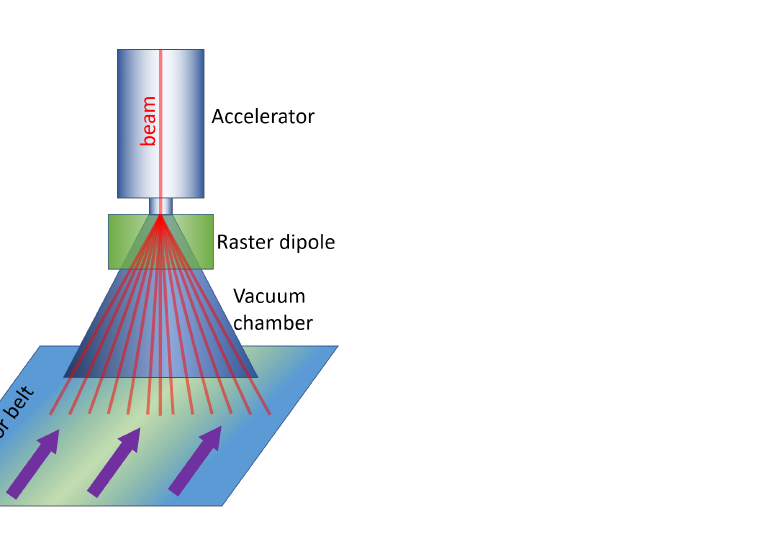
Figure 1. Irradiation system layout. It should be noted that the hide and conveyor system are in air, and the beam passes through a vacuum window to transition from the vacuum to the air